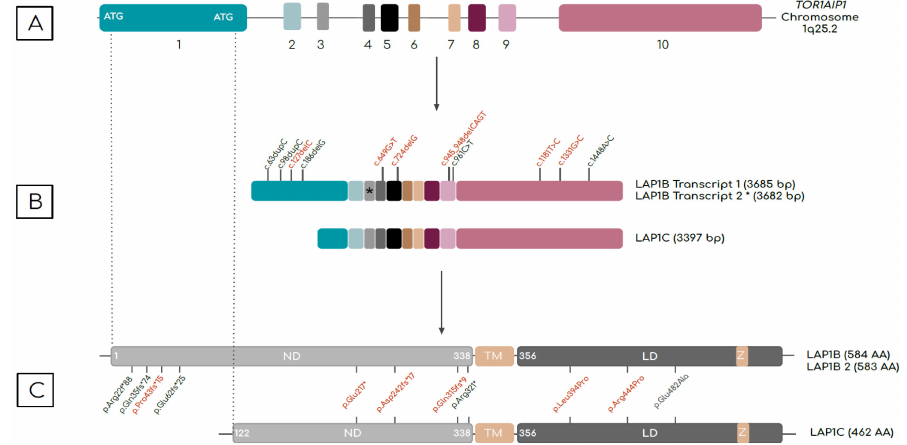
Figure 1. Schematic of (top to bottom) human TOR1AIP1 gene, the transcript variants, and LAP1 protein isoforms. ( A ) TOR1AIP1 has 10 exons represented by colored boxes. Two start codons are found in exon 1. Alternative translation start sites produce distinct transcripts. ( B ) Two LAP1B tran- scripts have identical sequence apart from a CAG trinucleotide in exon 3, indicated by an asterisk (*). ( C ) LAP1C is truncated at the N-terminus relative to LAP1B. LAP1B and LAP1C proteins, which dif- fer in the number of amino acids (AA) at the N-terminus, have three distinct domains: an N-terminal nucleoplasmic domain (ND), a transmembrane domain (TM), and a C-terminal luminal domain (LD). A zinc-finger motif (Z) is present in the C-terminal regions of both proteins. Mutations reported to date are indicated in transcript and protein schematics. Compound heterozygous mutations are indicated in red. Mutations that affect LAP1B seem to be associated with muscle involvement, whereas mutations that affect both isoforms result in early-onset multisystemic